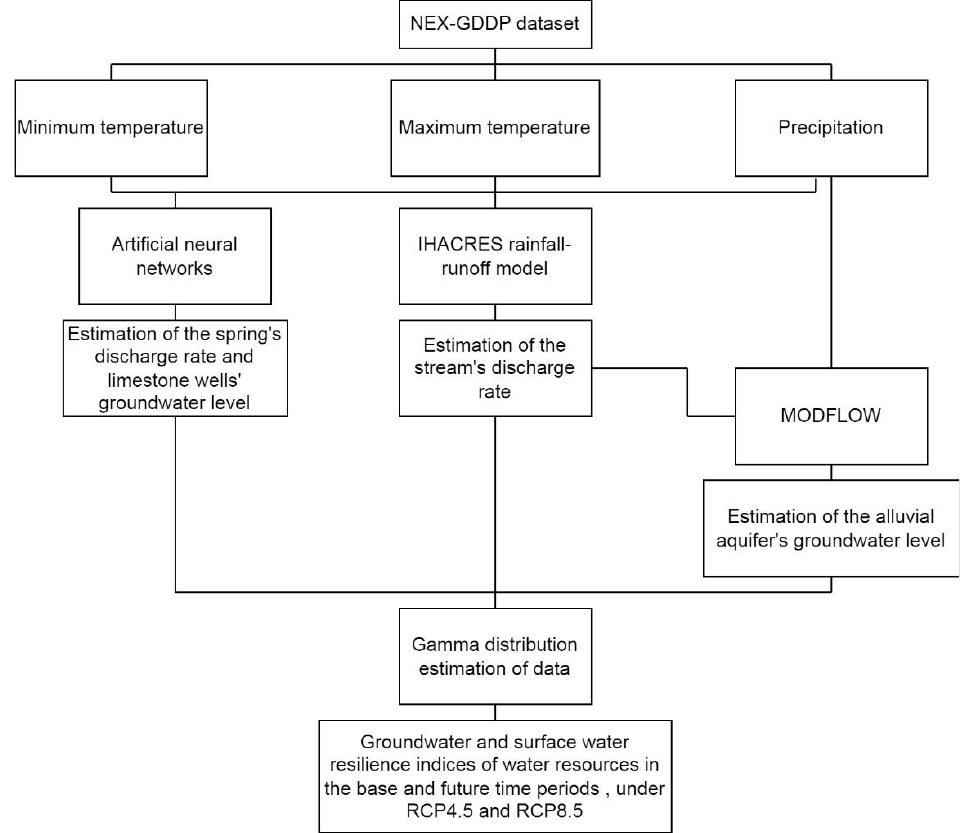
Figure 2. Overview of the applied approach for computing the resilience indices of water resources in the Lali region.